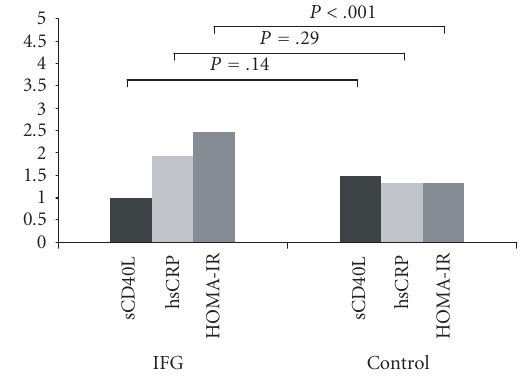
Figure 1: sCD40L (ng/mL) and hsCRP (mg/L) concentrations were similar, whereas HOMA-IR indexes were significantly higher in the IFG group in comparison with